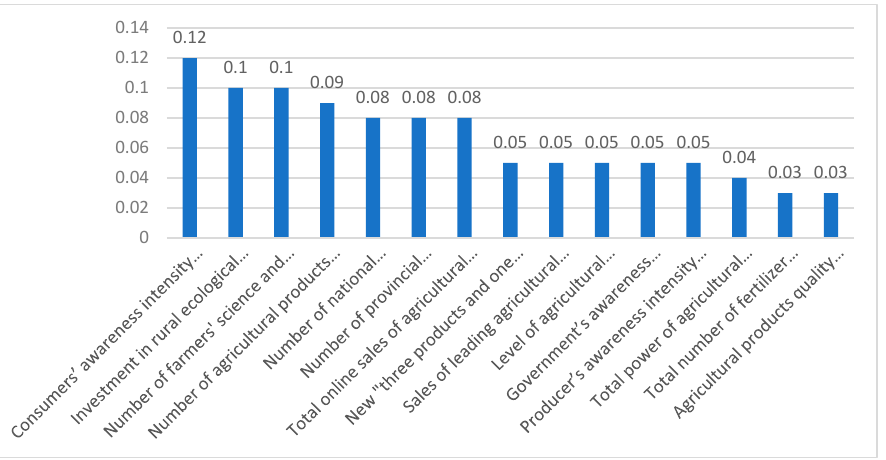
Figure 3. Dynamic Evaluation indicators weights of agricultural green development level in Yantai from 2011 to 2020.